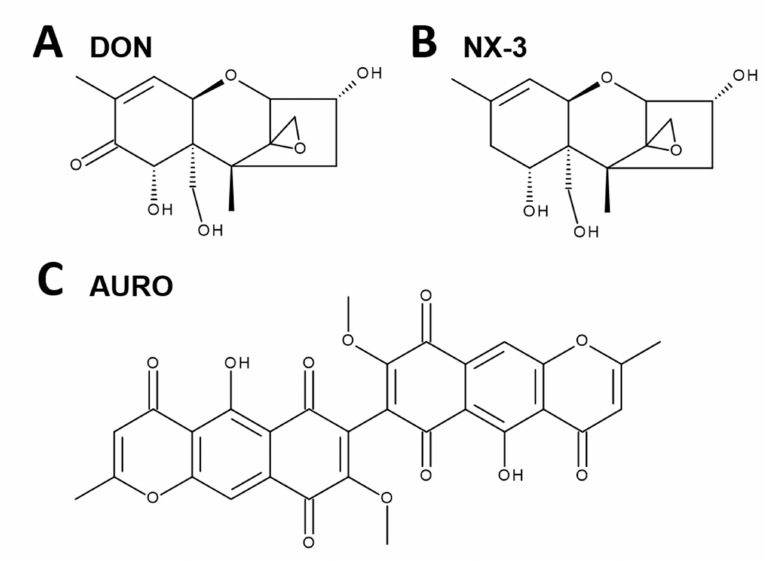
Figure 1. Chemical structures of the investigated Fusarium secondary metabolites: ( A ) deoxynivalenol (DON), ( B ) type A trichothecene (NX-3) and ( C ) aurofusarin